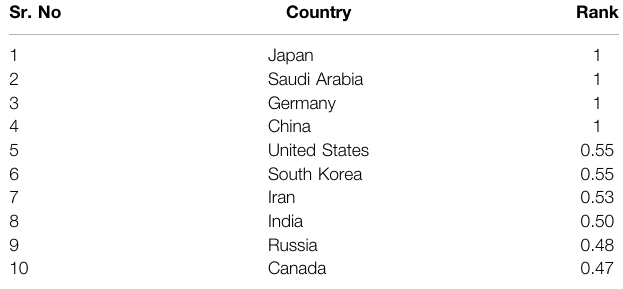
TABLE 5 | Top 10 countries ’ ranking score.